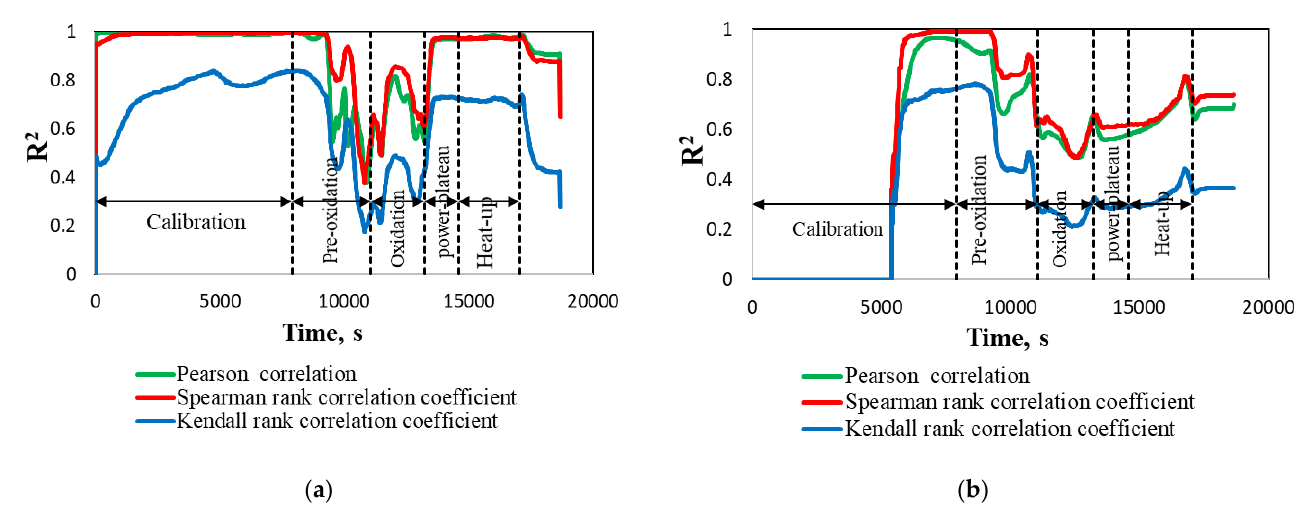
Figure 12. Determination coefficient. ( a ) Total hydrogen generation; ( b ) Cs/I release fraction.